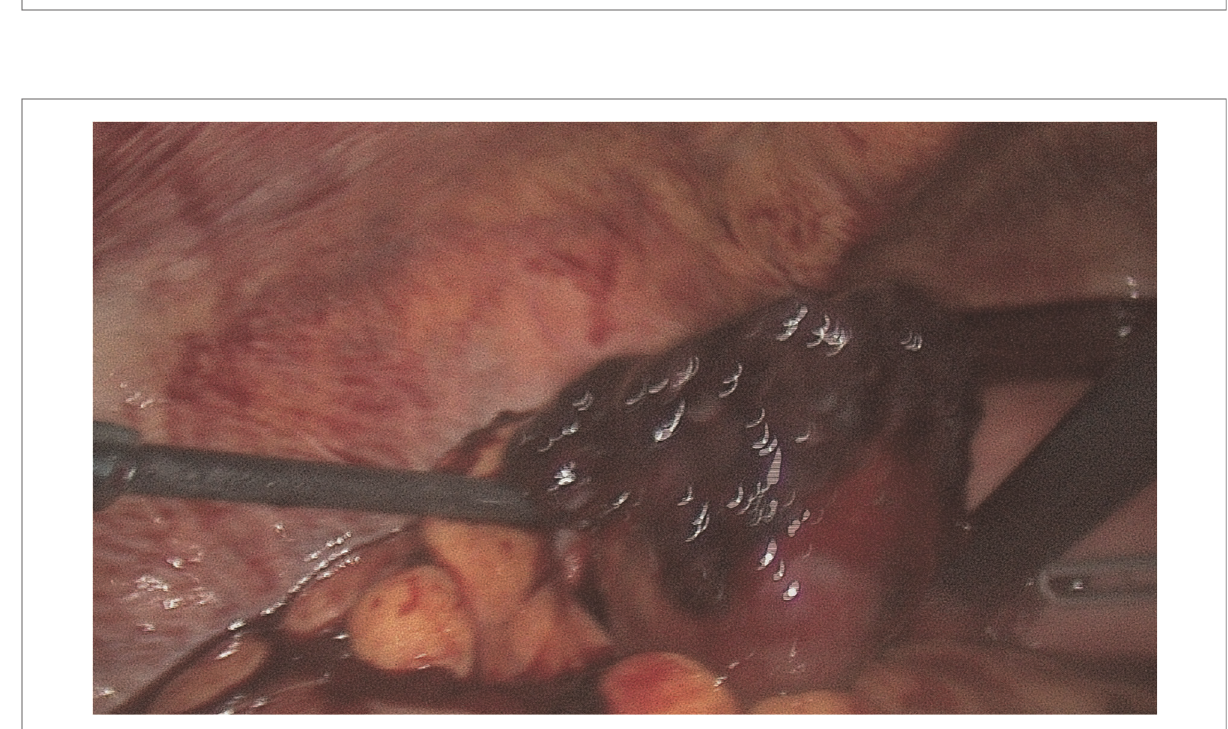
FIGURE 3 Intraoperative image of left fallopian tube ruptured by tissue with hydropic modi fi cations which appear as semi-transparent tiny glistening cysts of variable size on its surface. A salpingectomy was performed due to the rupture of the